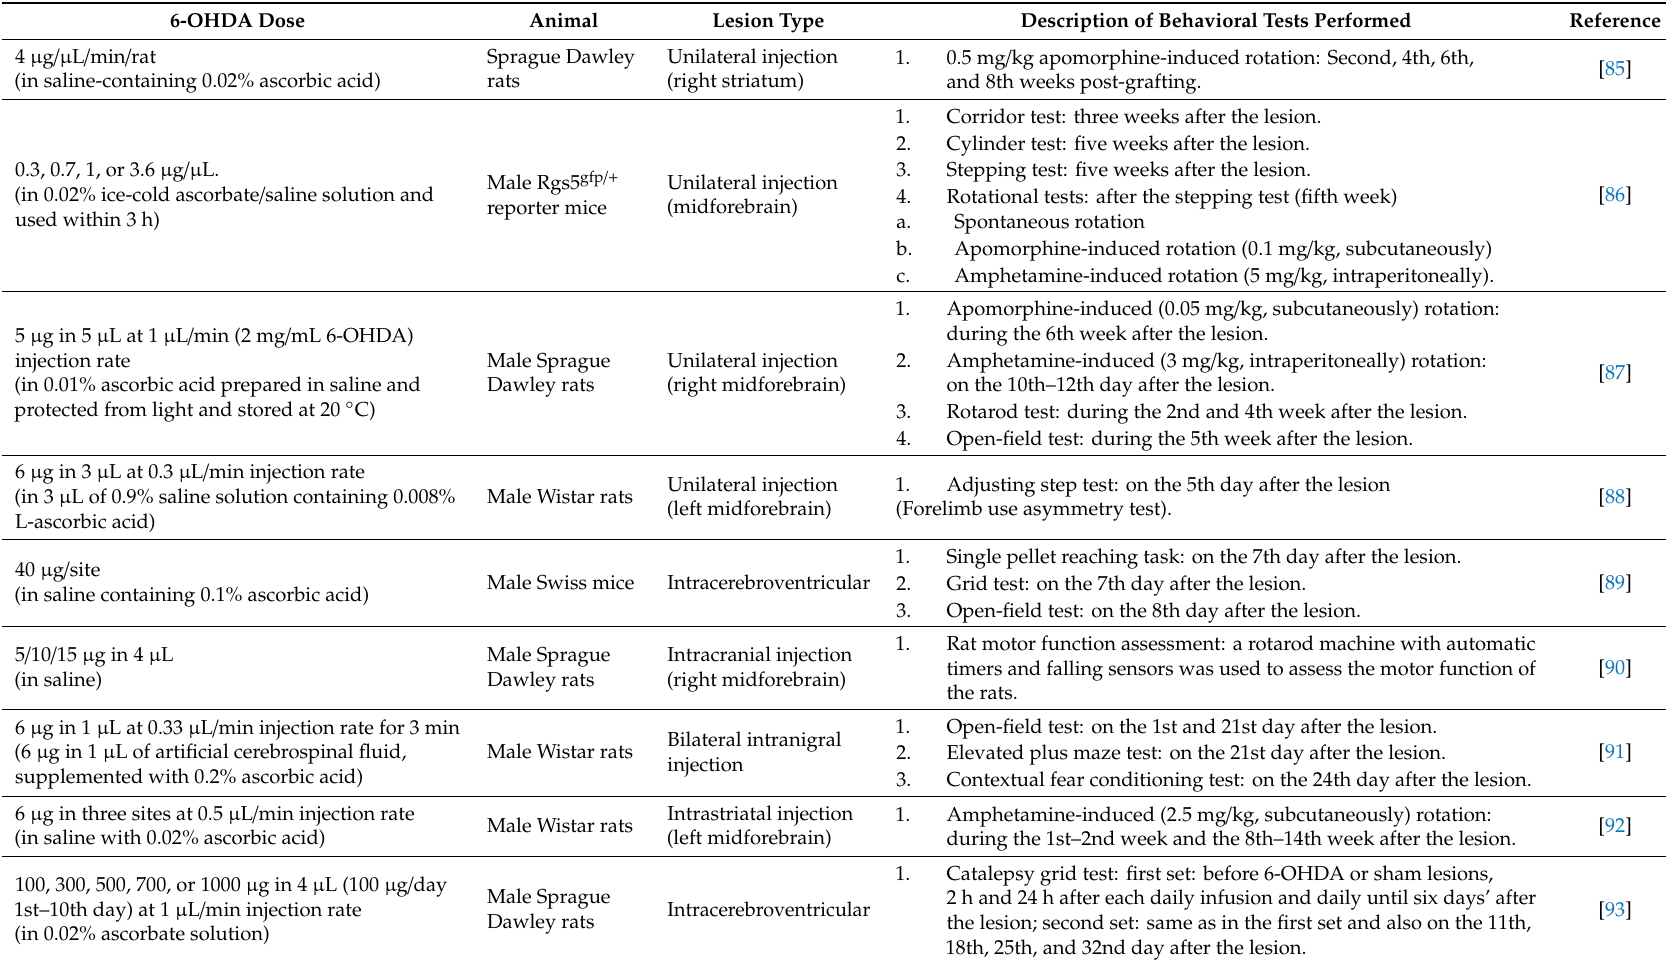
Table 2. The dose, lesion type and behavioral evaluating methods in each 6-OHDA-induced PD animal model. 6-OHDA Dose Animal Lesion Type Description of Behavioral Tests Performed Sprague Dawley